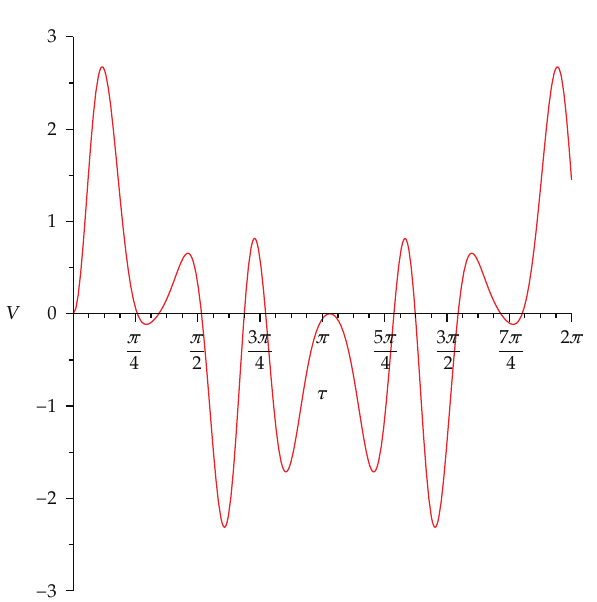
Figure 9: The evolution of the volume of the trefoil knot universe with respect to the cosmic time τ for (cid:2) 3.17 (cid:3) .